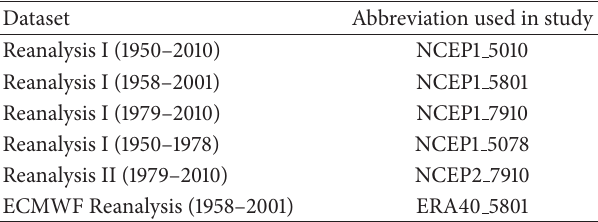
Table 1: Cyclone track climatology reanalysis